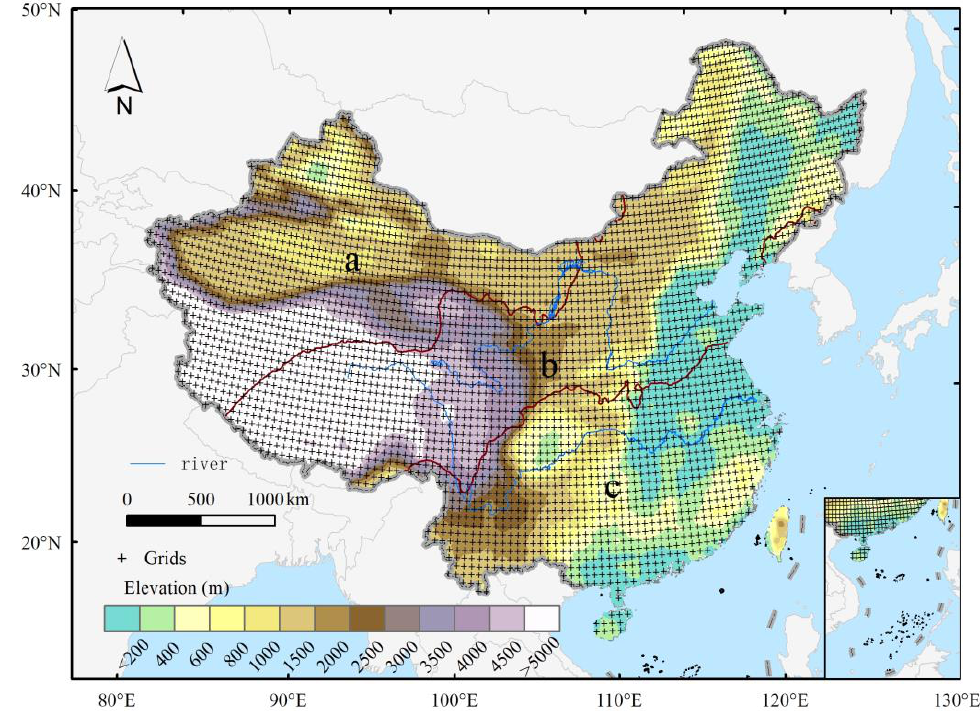
Figure 1. Spatial distribution of meteorological grids and three climatic regions in China: ( a ) arid region, ( b ) semi-arid and semi-humid region, and ( c ) humid region (red curves are the boundary between different climatic zones).